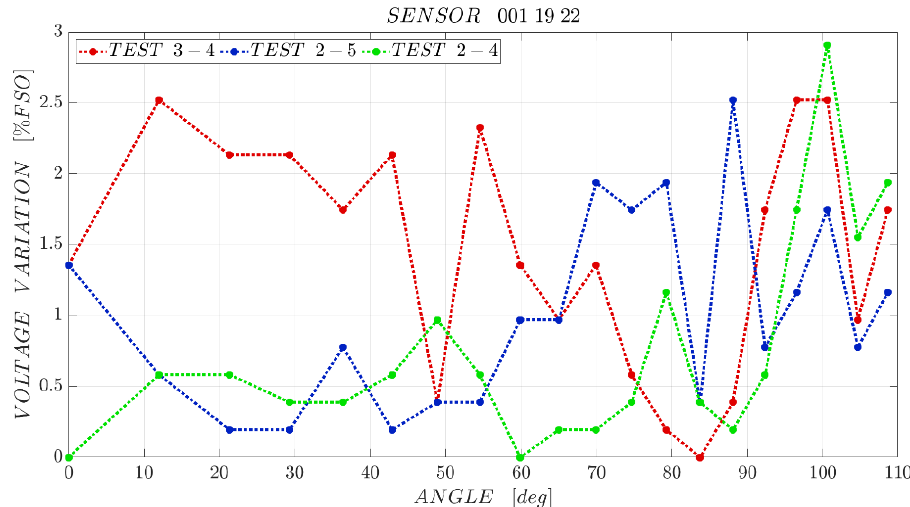
Figure 21. Sensor 001 19 22: repeatability (backward path).